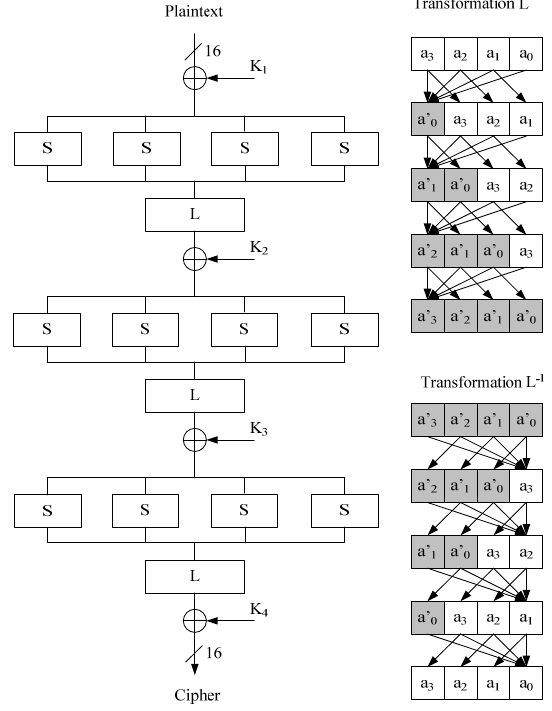
Figure 2. General data flow diagram of S-KN2.